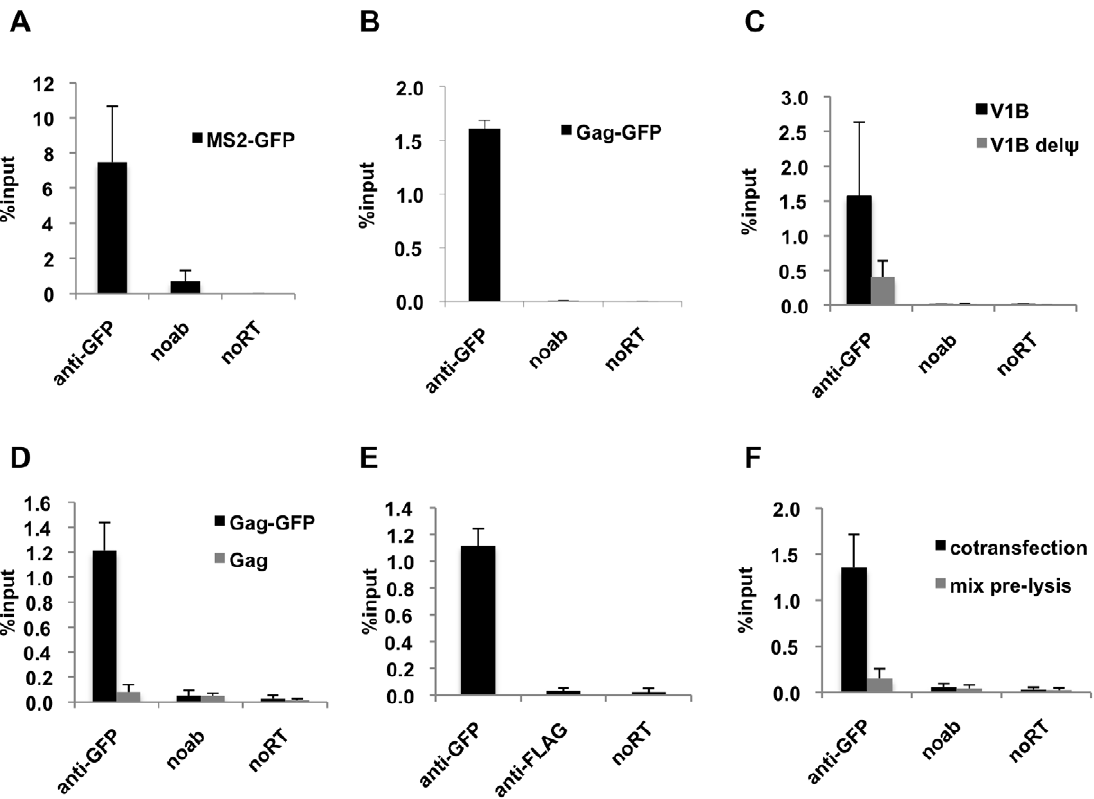
Figure 1. Efficient immunoprecipitation of HIV-1 genomes by MS2-GFP or Gag-GFP. ( A and B ) Lysates of 293T cells coexpressing V1B- MS2 RNA and either MS2-GFP (A) or Gag-GFP (B) were prepared at 24-h post-transfection. RNA-protein complexes were immunoprecipitated using anti-GFP antibodies. Immunoprecipitations without antibodies (noab) were carried in parallel. Immunoprecipitated V1B-MS2 RNA was quantitated by qRT-PCR and is represented as fraction of input RNA prior to immunoprecipitation (% input). ( C ) RNA-IP assay was performed as in (B) where the viral genome was either V1B or V1B DY . ( D ) RNA-IP assay in 293T cells coexpressing V1B-MS2 viral RNA and Gag-GFP or untagged Gag. ( E ) RNA-IP assay was performed as in (B) but an immunoprecipitation using anti-FLAG antibodies was included as negative control. ( F ) 293T cells separately expressing Gag-GFP or V1B-MS2 viral RNA were mixed before cell lysis followed by immunoprecipitation (gray bars). RNA-IP assay was then performed as in (B). Immunoprecipitations from 293T cells that were cotransfected with Gag-GFP and V1B-MS2 plasmids were carried in parallel (black bars). Data in (A-F) represents the average of two independent experiments, where error bars indicate the range between the averages of two experiments. RNA extracted from 10% of the cell lysate that was used in immunoprecipitation was subjected to qRT-PCR without reverse transcription (noRT) to control for the presence of contaminating viral DNA.